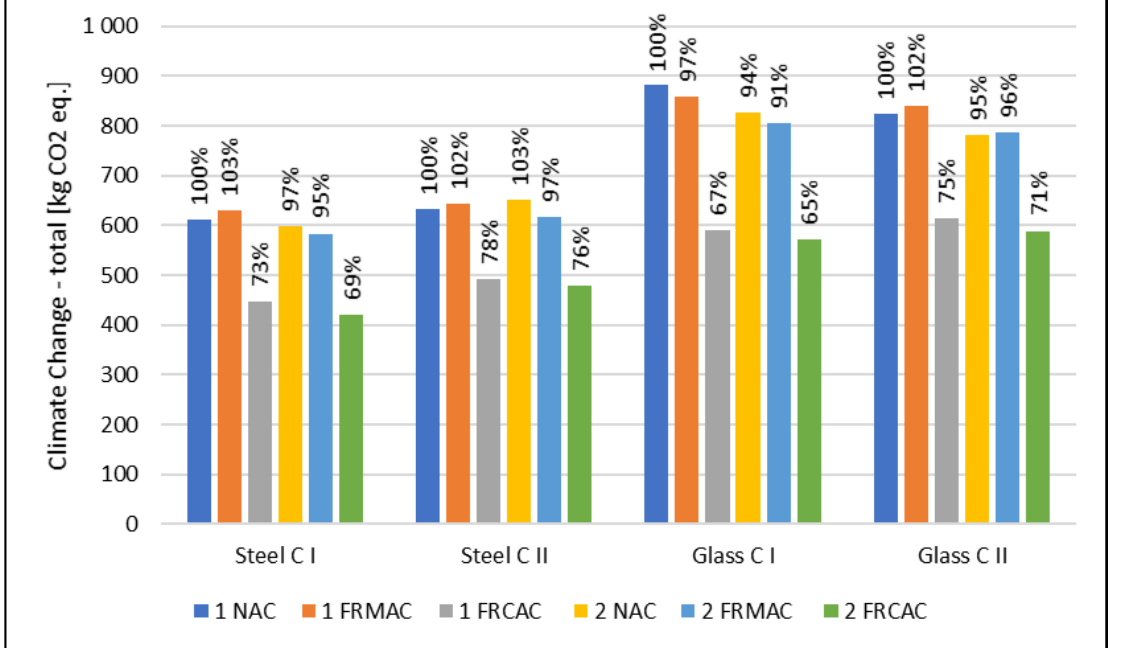
Figure 5. Results of climate change for concrete slab designed according to the serviceability limit state. (1) The compensation by varying thickness of slab; (2) the compensation by varying reinforce- ment level.